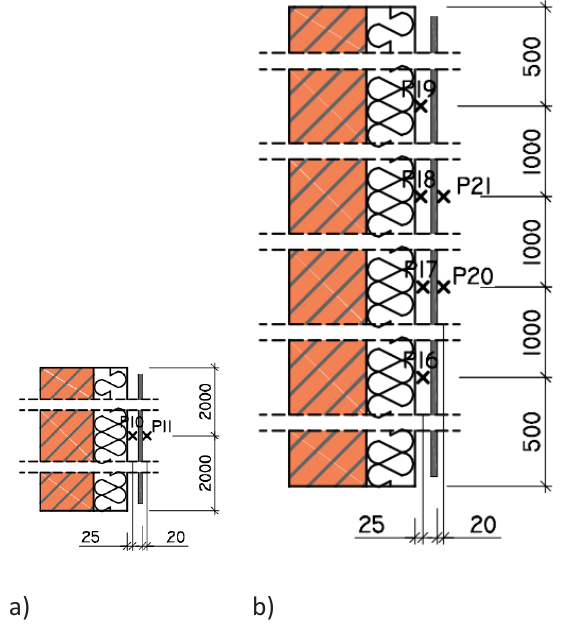
Figure 6: Location of temperature measurement points: a) closed- joint ventilated facade; b) open-joint ventilated facade.